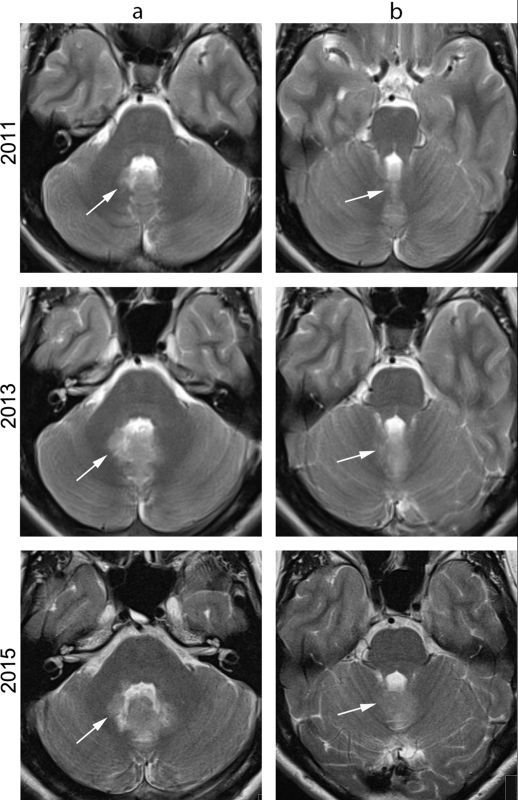
T2 weighted MR images at the level of the pons (a) and at the level of the mesencephalon (b) at first presentation in 2011 (first row), at second presentation in 2013 (second row) and at time of diagnosis in 2015 (third row). In 2015, an abnormal T2 hyperintense signal is seen on the dorsolateral side of the fourth ventricle (arrows), with little mass effect. Retrospectively, this area could also be seen on previous MRI examinations, albeit less clearly.